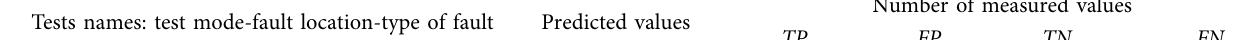
Table 6: Predicted values and measured TP , FP , TN , and FN values.